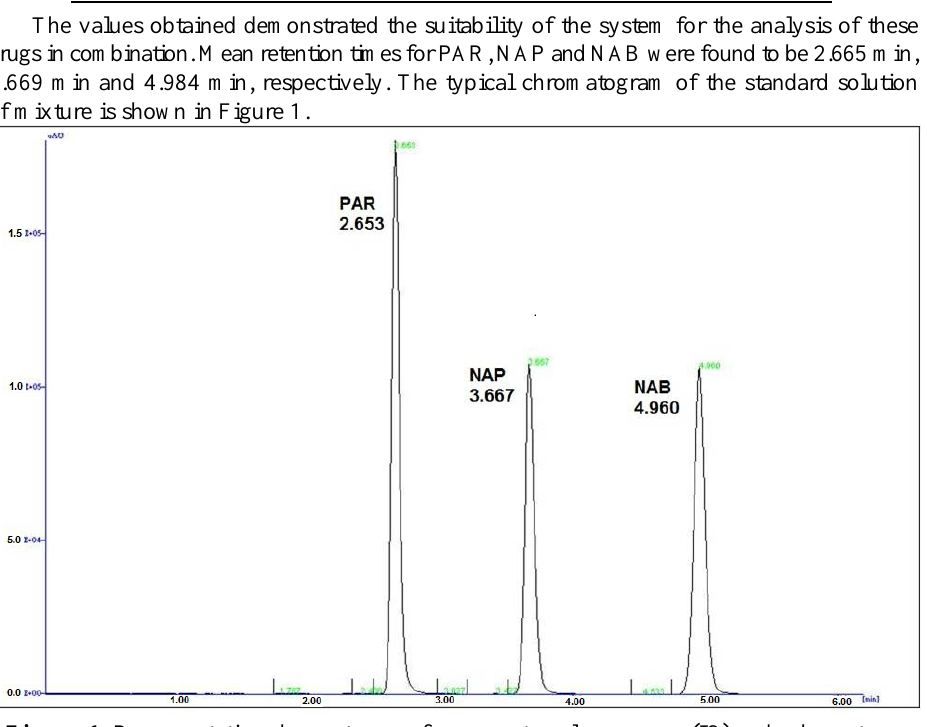
Figure 1. Representative chromatogram for paracetamol, naproxen (IS) and